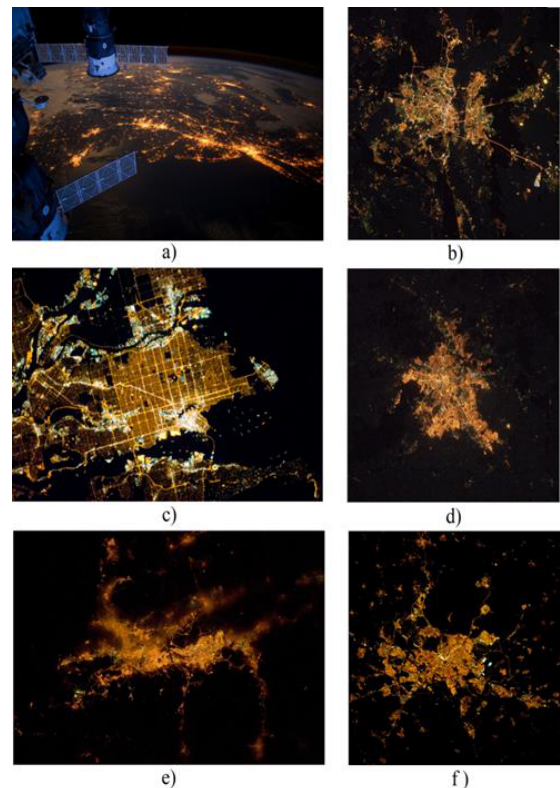
Figure 1. Pictures of cities at night made from a height of 300 km: